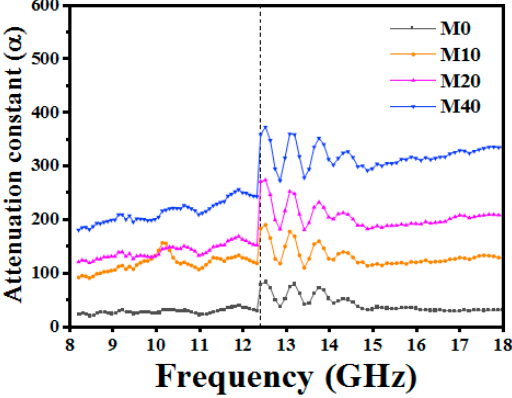
Figure 11. Attenuation constant ( α ) of all samples.